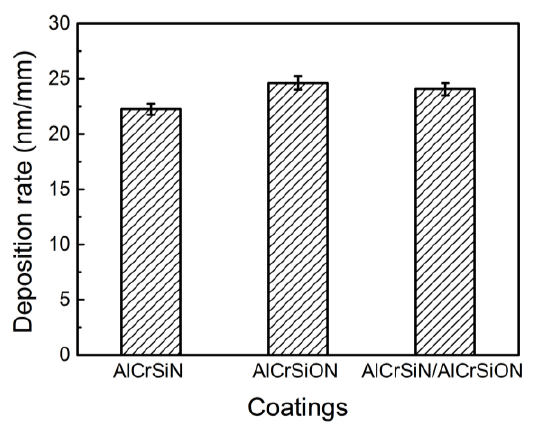
Figure 2. Deposition rates of the AlCrSiN coating, AlCrSiON coating, and AlCrSiN/AlCrSiON duplex coating.